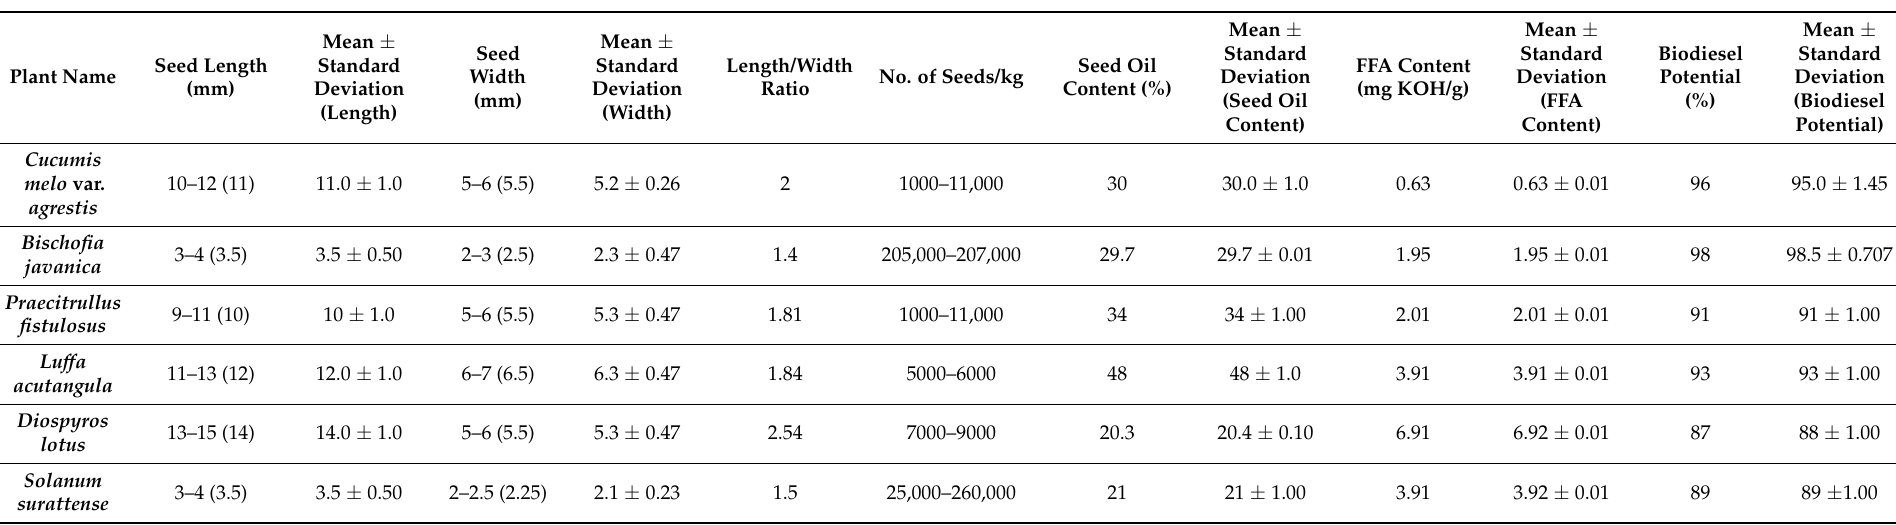
Table 2. Quantitative characteristics of seed-bearing energy